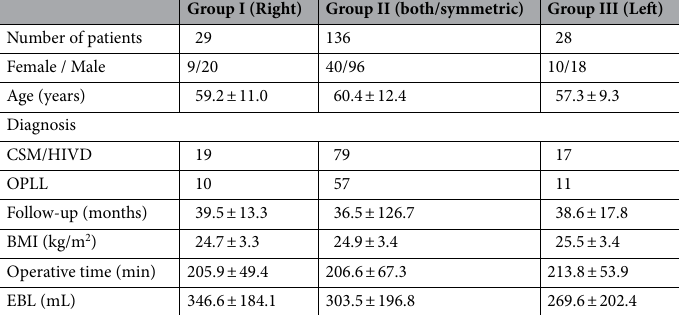
Table 3. Patient characteristics based on dominant myelopathy symptom side. CSM indicated cervical spondylotic myelopathy; HIVD herniated intervertebral disc; OPLL ossification of posterior longitudinal ligament; BMI body mass index; EBL estimated blood